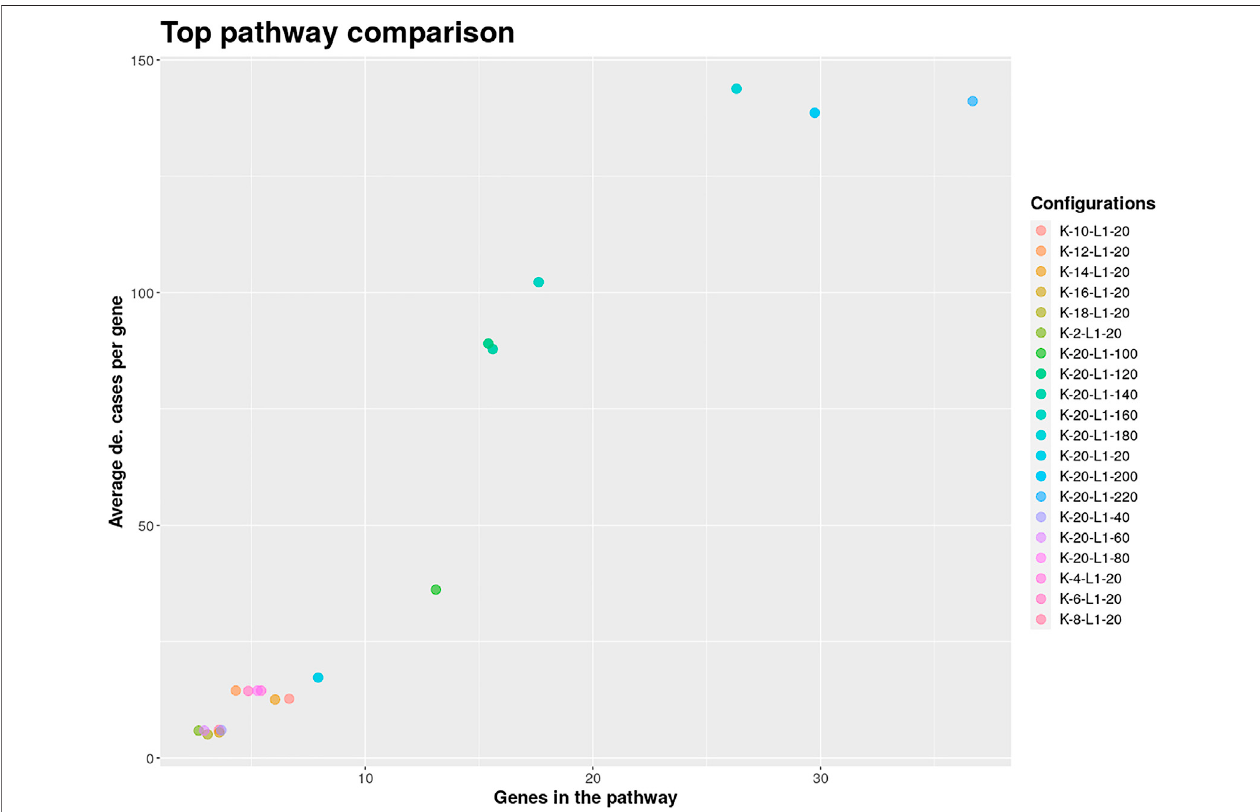
FIGURE3| Pathwaycomparisonplotscanbeutilizedto fi ndtheoptimalpathwayintheextractedsolution.Theshownpathwayswereextractedfromtheanalyzed GEO SARS-CoV-2 dataset and used to limit the further exploration to con fi gurations with at least 100 on average differentially expressed genes per case.